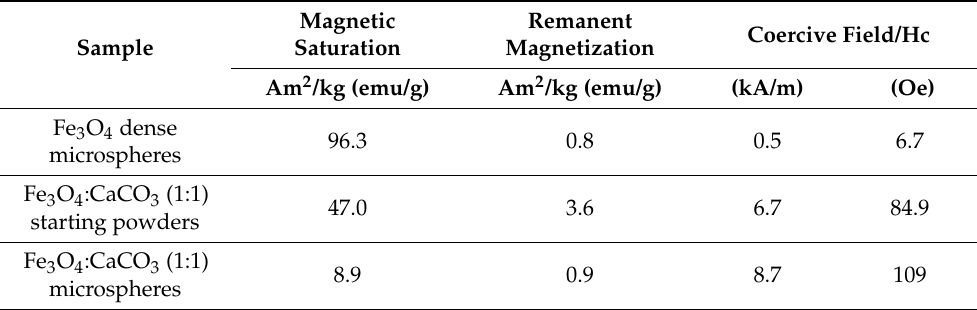
Table 6. Magnetic saturation, remanent magnetisation and coercive field values of Fe 3 O 4 dense